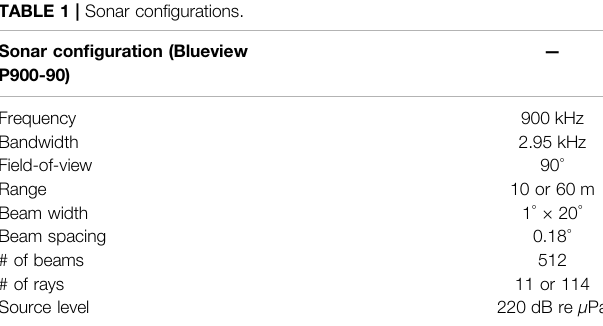
TABLE 1 | Sonar con fi